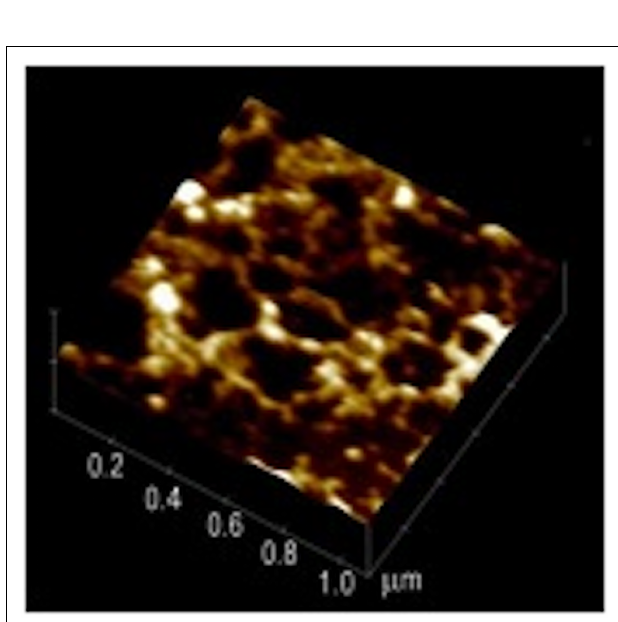
FIGURE 2 |Atomic force microscopy image of endoscopic specimen of human mucus gel .This 1 µ m × 1 µ m image reveals a network with a “pearl-necklace” morphology formed by mucin aggregates. Reproduced from Hong et al. (55) with permission from American Chemical